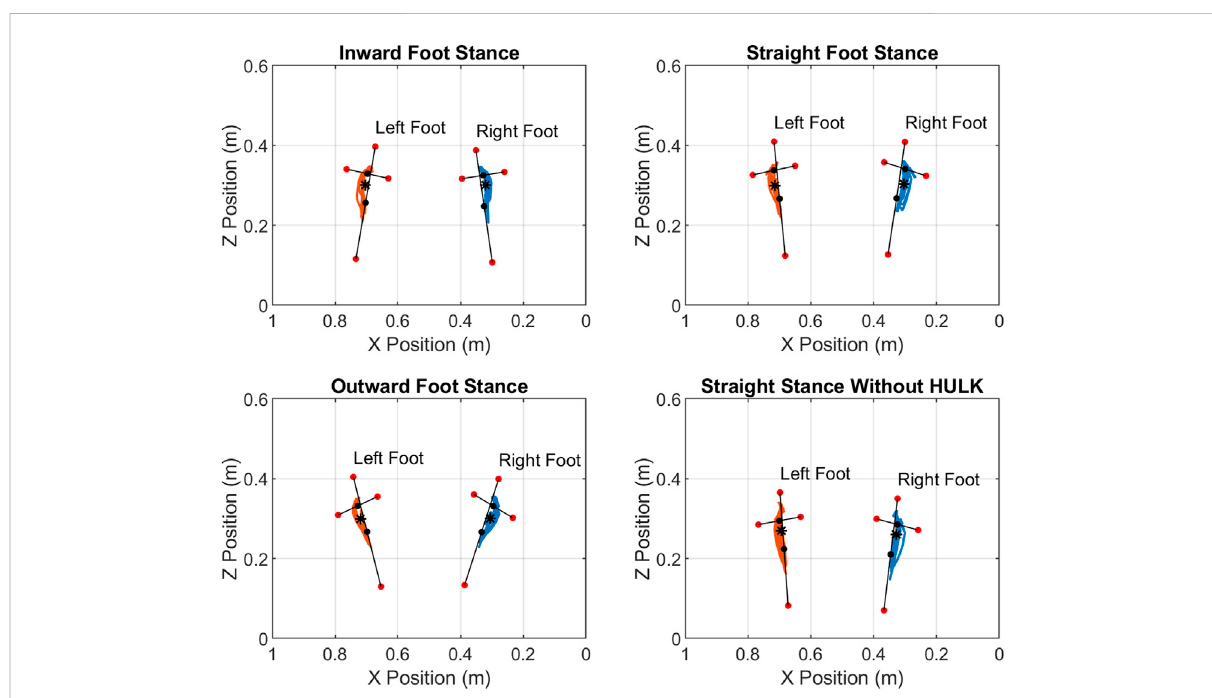
FIGURE 7 Center ofPressureduring theheelraise repetitionsfor thefour differentcon fi gurationsinvestigated: inward,straight, andoutward foot stances withtheHULKdevice,andstraightstancewithouttheHULKdevice.Thebluelineindicatesthecenterofpressureoftherightfoot,andtheorangeline indicates the center of pressure of the left foot. Red dots indicate the location of motion capture markers on the toe, heel, outside, and inside of the left and right feet. Black dots indicate center points of the toe/heel line and the inside/outside line. The asterisks represent the centroid of the centerofpressurethroughtheentiresetofHRrepetitions.Note:thexaxishasitsoriginontherightsideofthe fi guresandincreasestowardstheleft. This is due to the origin of the force plates being located in the bottom right